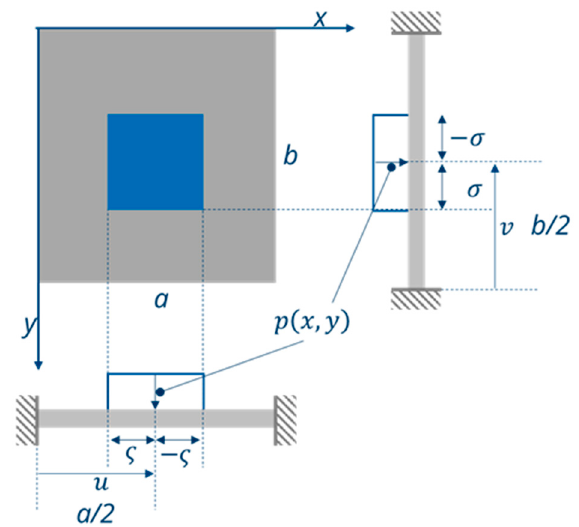
Figure 5. Entirely clamped rectangular plate (grey) with area-related out-of-plane force p ( x , y ) acting on the middle of the plate (blue area). The center of this area is located at u = a / 2 and v = b / 2, and its size is 2 σ × 2 ς (adapted from Reference [27]).